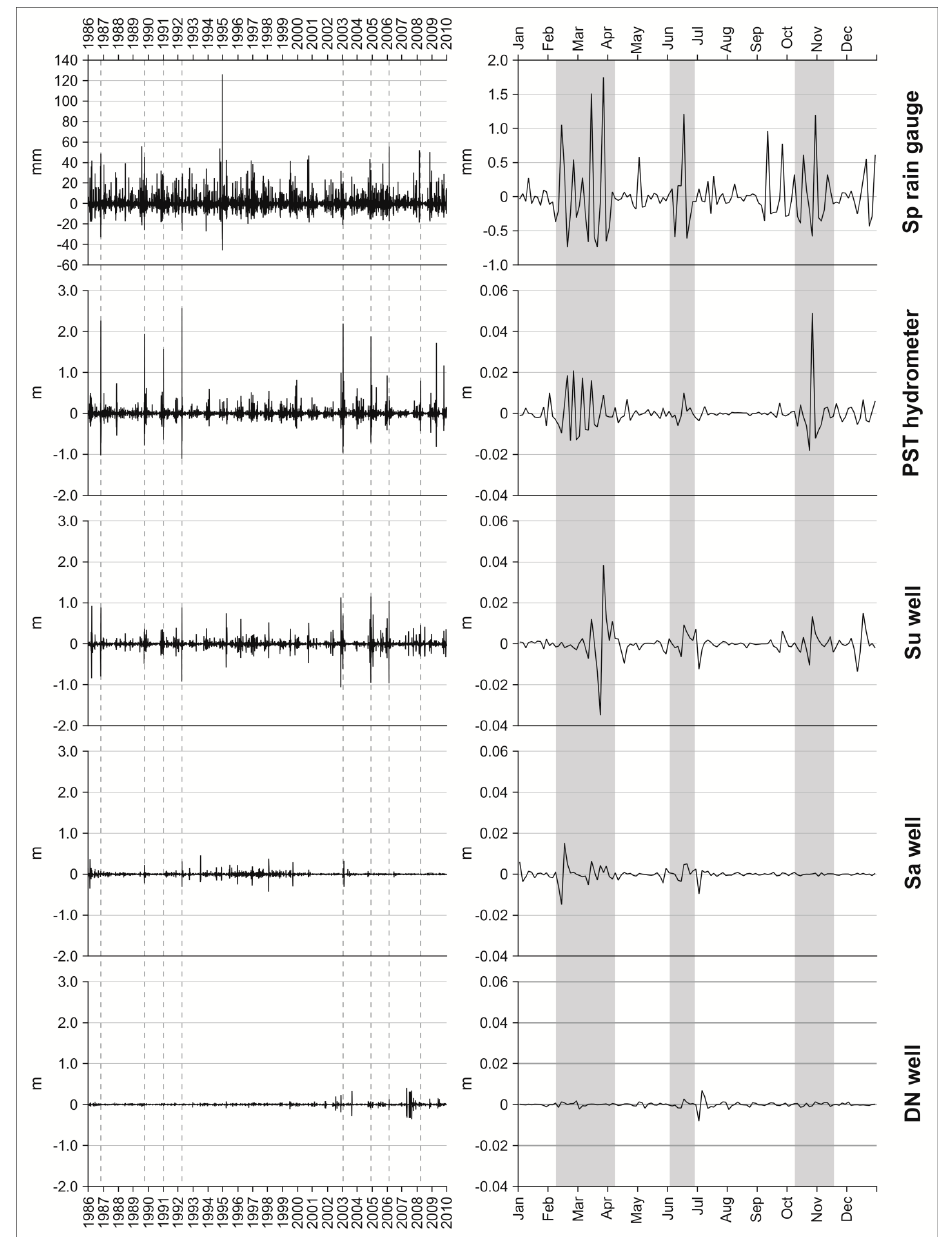
Figure 7. Residual time series ( left ); and year type ( right ).